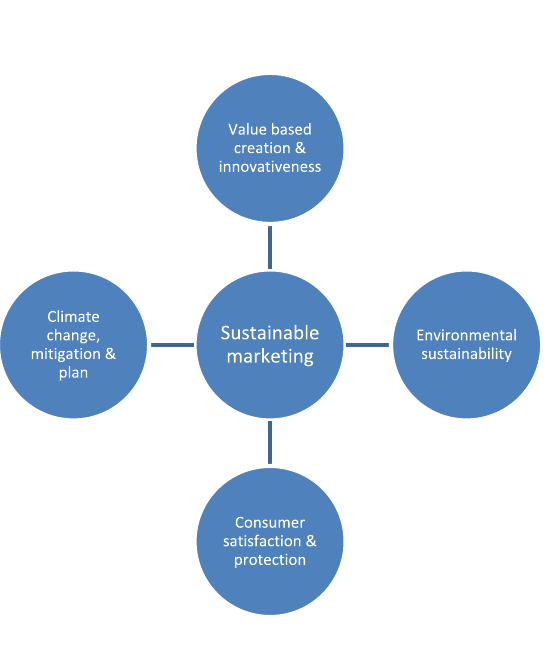
Fig. 5 Proposed Model of Sustainable Marketing: ‘Appendix 1 in Fig. 5 as titled: “Proposed Model of Sustainable Marketing”; and proposed. Author Source & Present